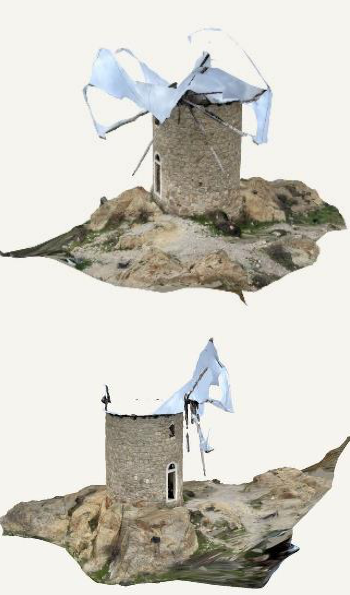
Figure 8. The 3D model view of windmill from smartphone app (Polycam).